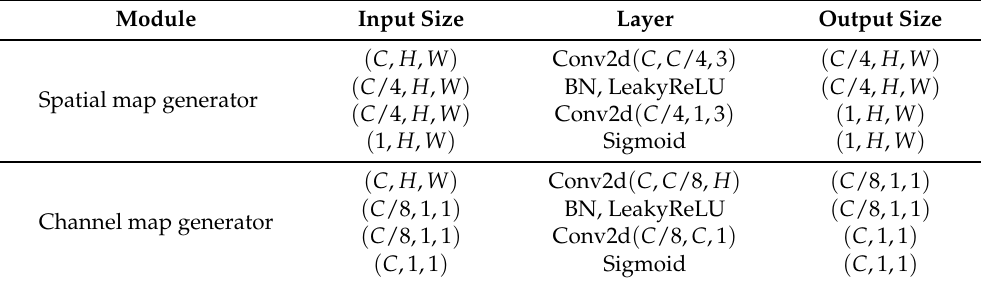
Table 1. Details of network layers for generating the spatial and channel probabilistic